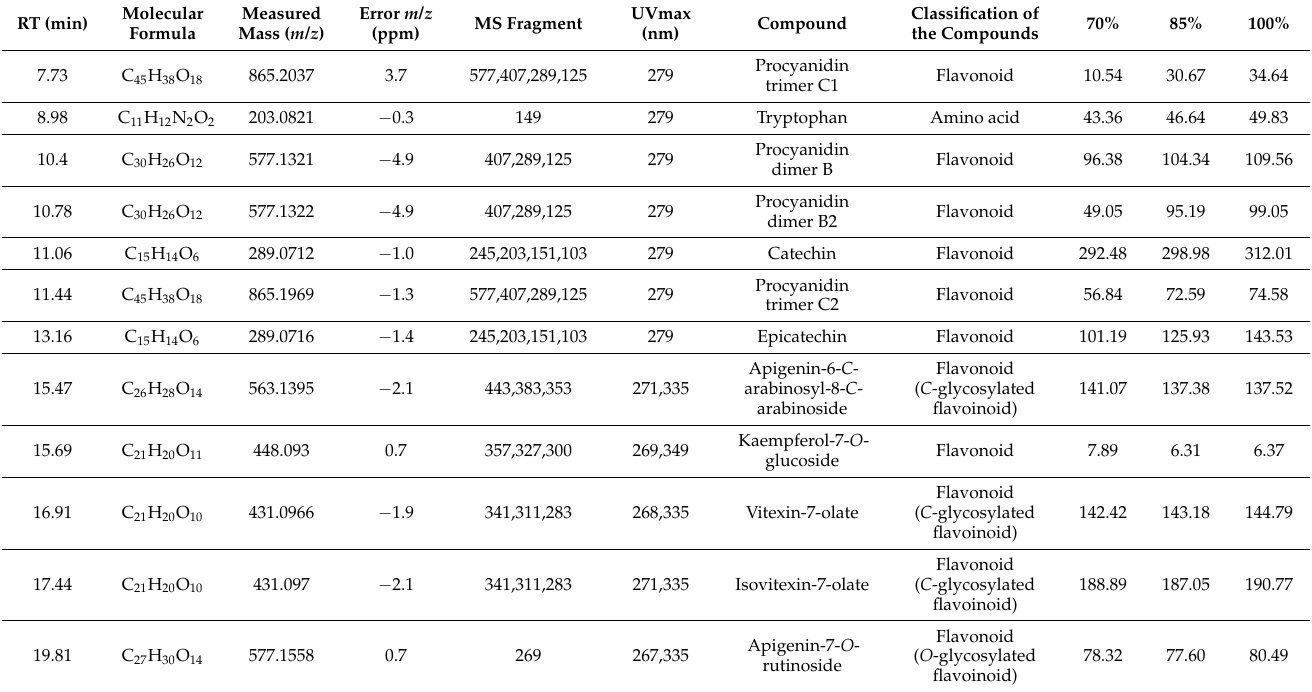
Table 3. Identification and the mean abundance of phytochemicals (mg L − 1 ) in Jatropha curcas extracts using 70%, 85% and 100%